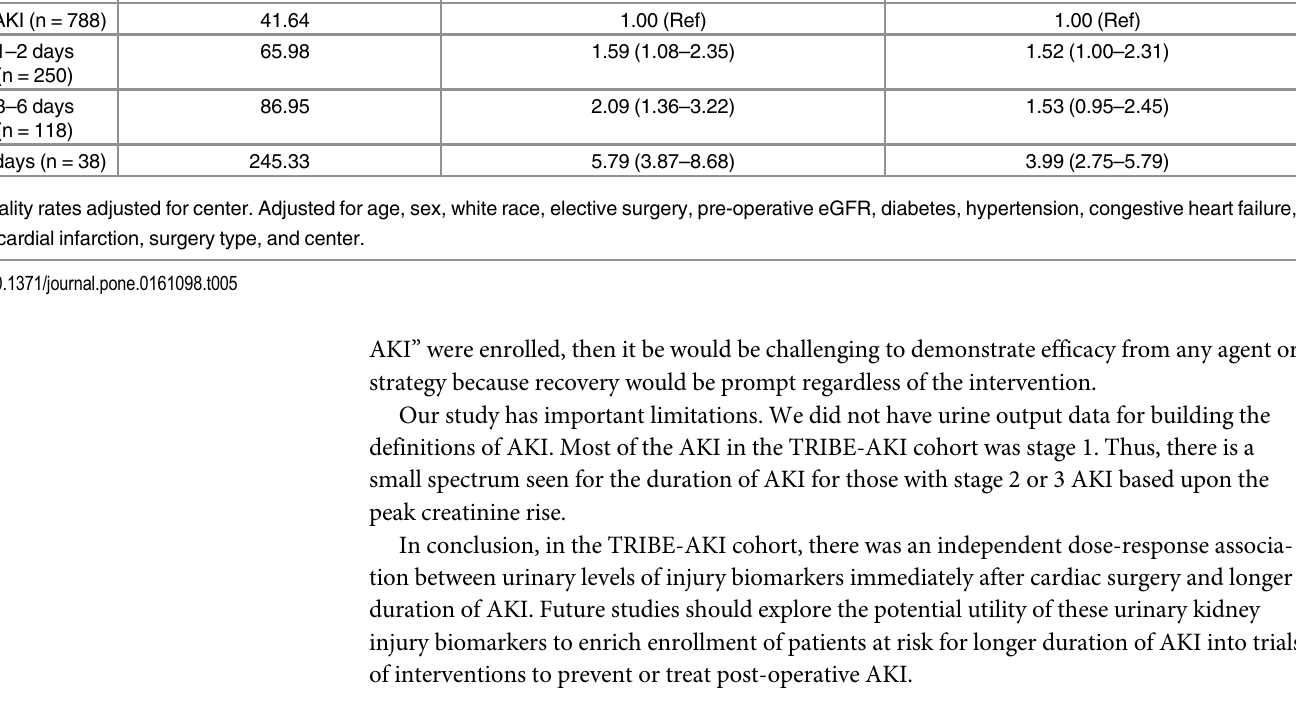
S1 Table. Log-transformed and Quintile Associations of Urine Creatinine-Normalized Bio- markers for Increased Duration Category. Data presented as adjusted and adjusted odds ratios per log increase and by quintile of biomarker levels (with quintile 1 as reference). All